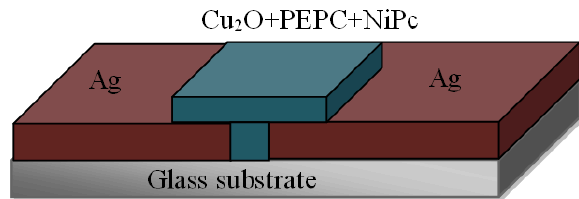
O-PEPC-NiPC/Ag humidity 2